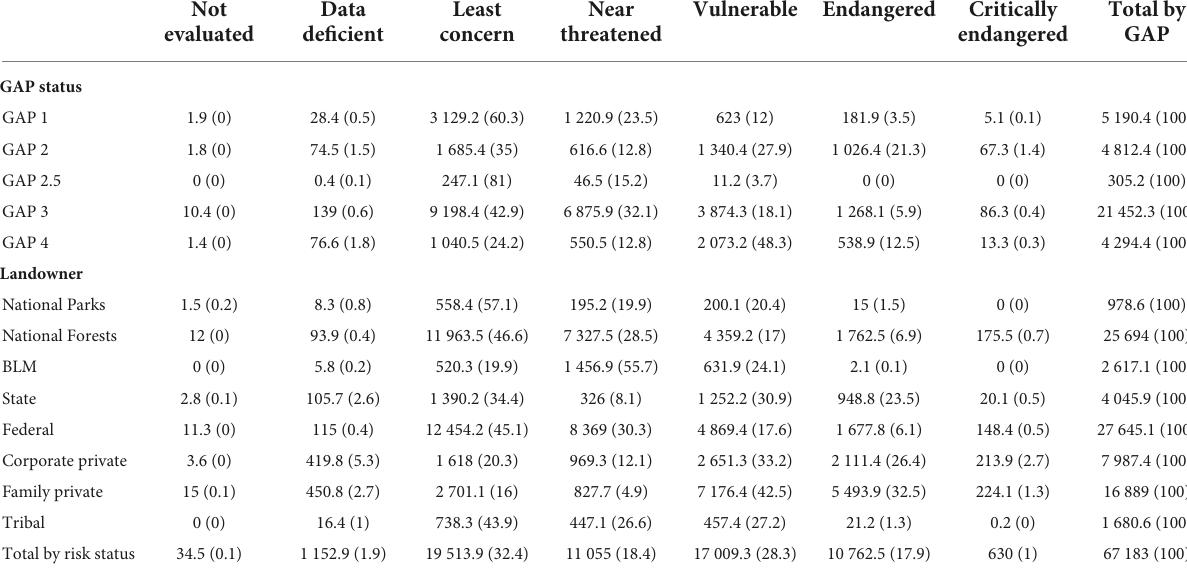
TABLE 6 Area of land ( × 1000 ha) and percentage area (parentheses) for each of the identified Red Listed Ecosystem (RLE) risk status by GAP and